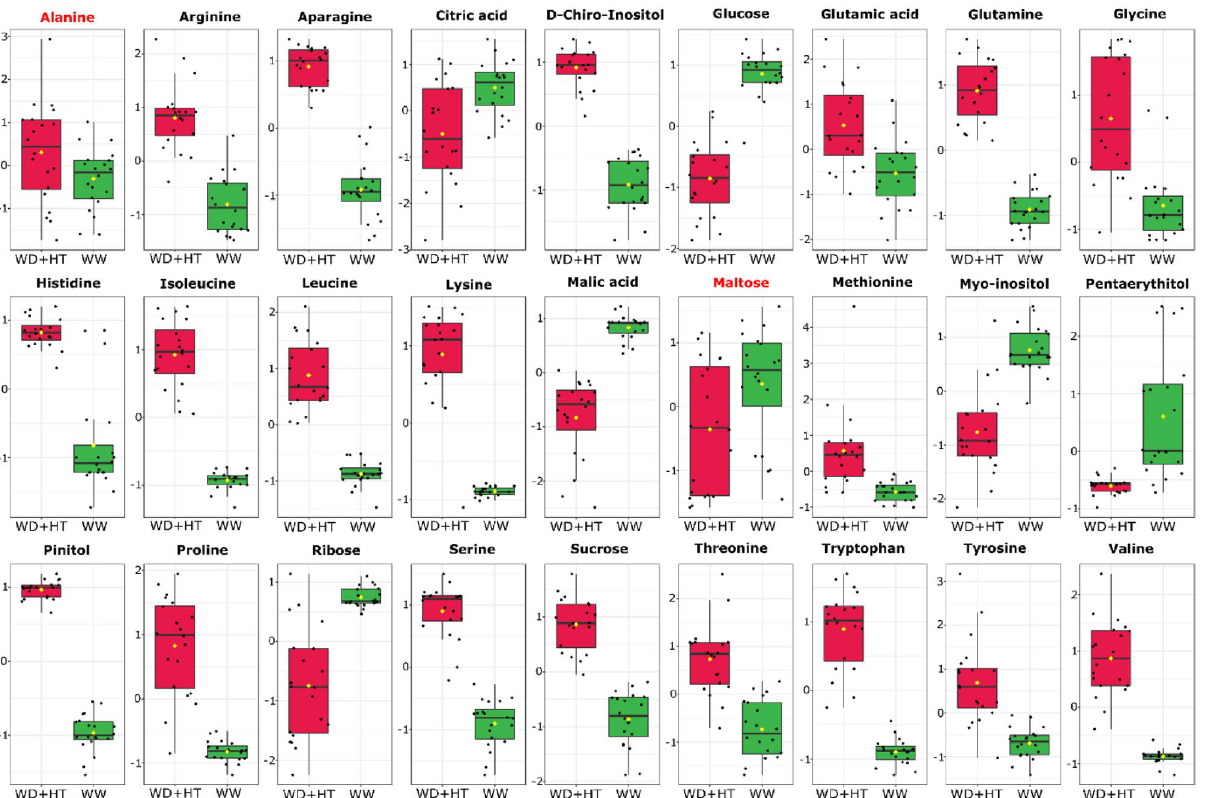
Figure 6. Box plots of metabolites identified as water deficit combined with high temperature (WD + HT) biomarkers. Green and red box plots indicate the relative content of metabolites found in soybean plants under well-watered (WW) and WD + HT conditions, respectively. Biomarkers were identified based on receiver operating characteristic (ROC) curves using Log and Auto-scaling normalized data on the MetaboAnalyst platform 98 . Metabolites in black and red indicate statistical difference at p < 0.001 and p < 0.05,